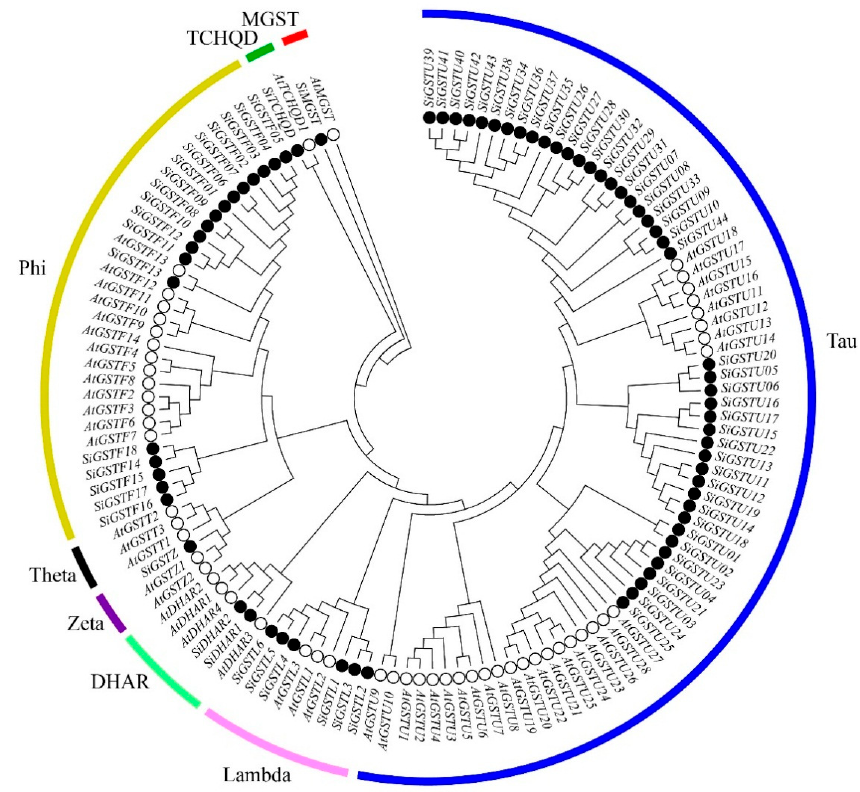
Figure 1. Phylogenetic tree of GST proteins among foxtail millet and A. thaliana . The GST protein sequences of 73 foxtail millet and 55 A. thaliana are divided into eight classes. Different subfamilies are marked as different colors.